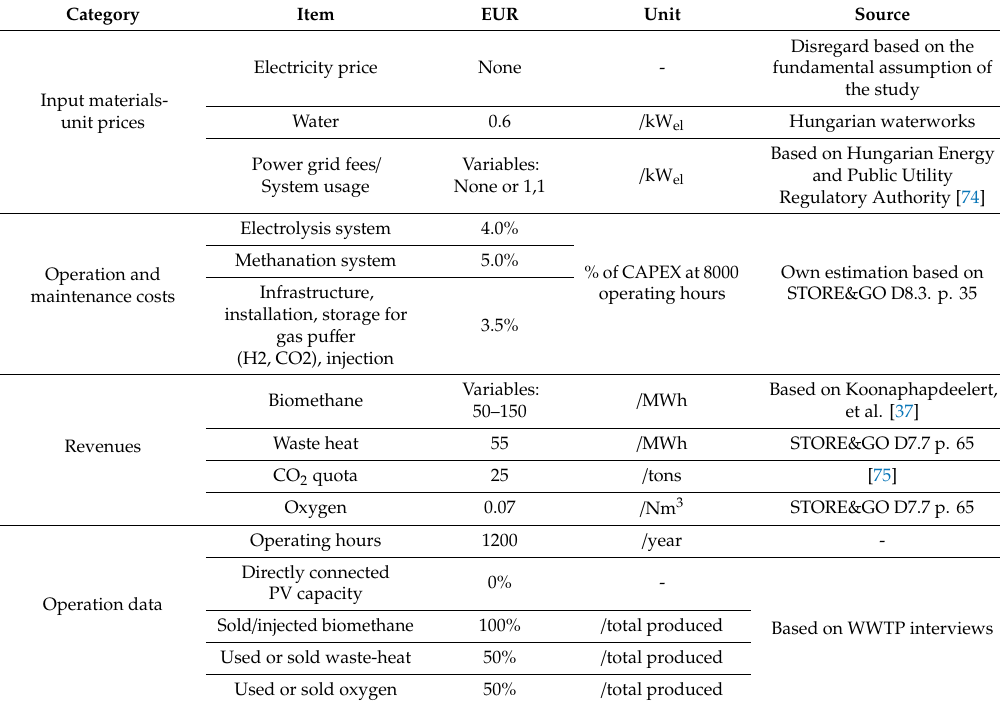
Table A2. Base case for operative expenses and revenues at a single